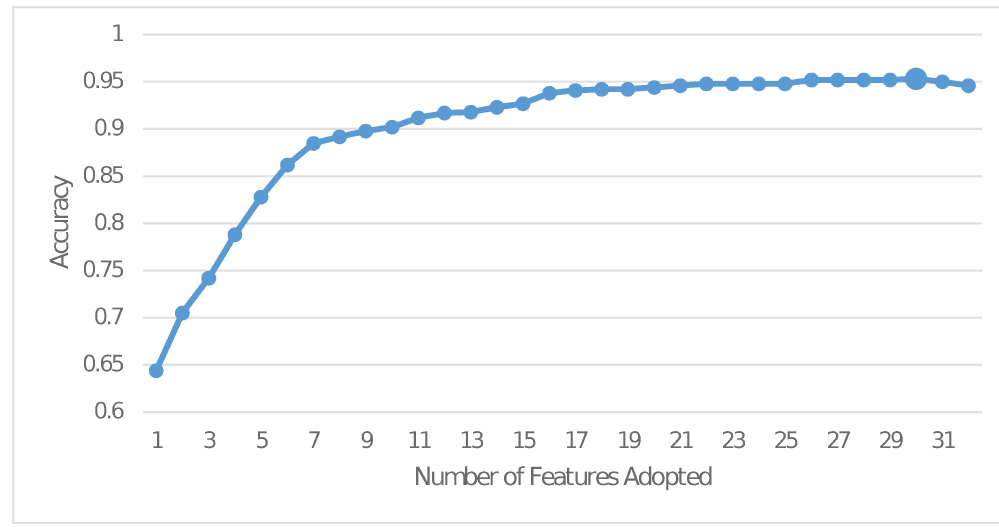
Fig 6. Accuracy of different subsets of